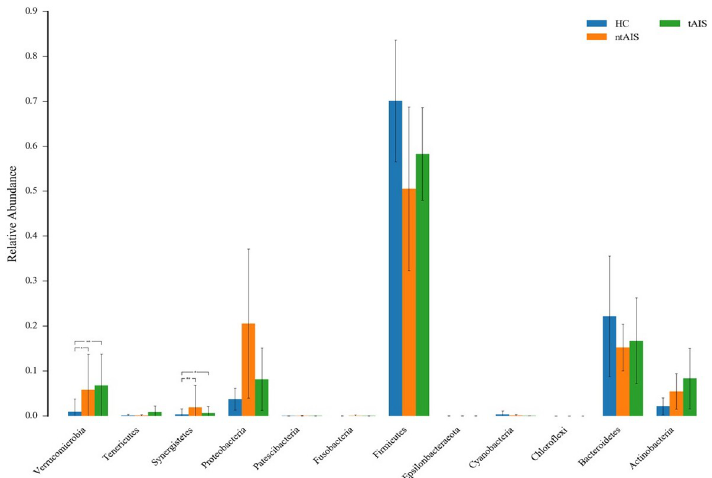
Fig 5. The most abundant microbiotic components of three groups at the phylum level. AIS: Acute ischemic stroke; tAIS: Patients with PHS; ntAIS: Patients with non-PHS; HC: Healthy controls.